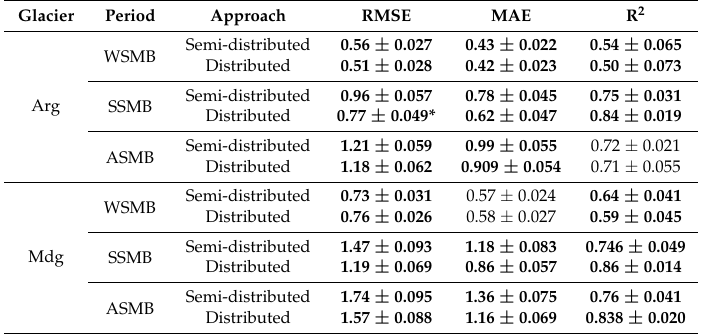
Table 8. R 2 , MAE and RMSE average and standard deviations values from the 100 sample bootstrapping for the observed and simulated SMB for Mer de Glace (Mdg) and Argenti è re (Arg) glaciers (based on the distributed and semi-distributed approaches. Error metrics in bold note p -values of the T-student test lower than 0.01 (99% confidence interval for rejecting null hypothesis).